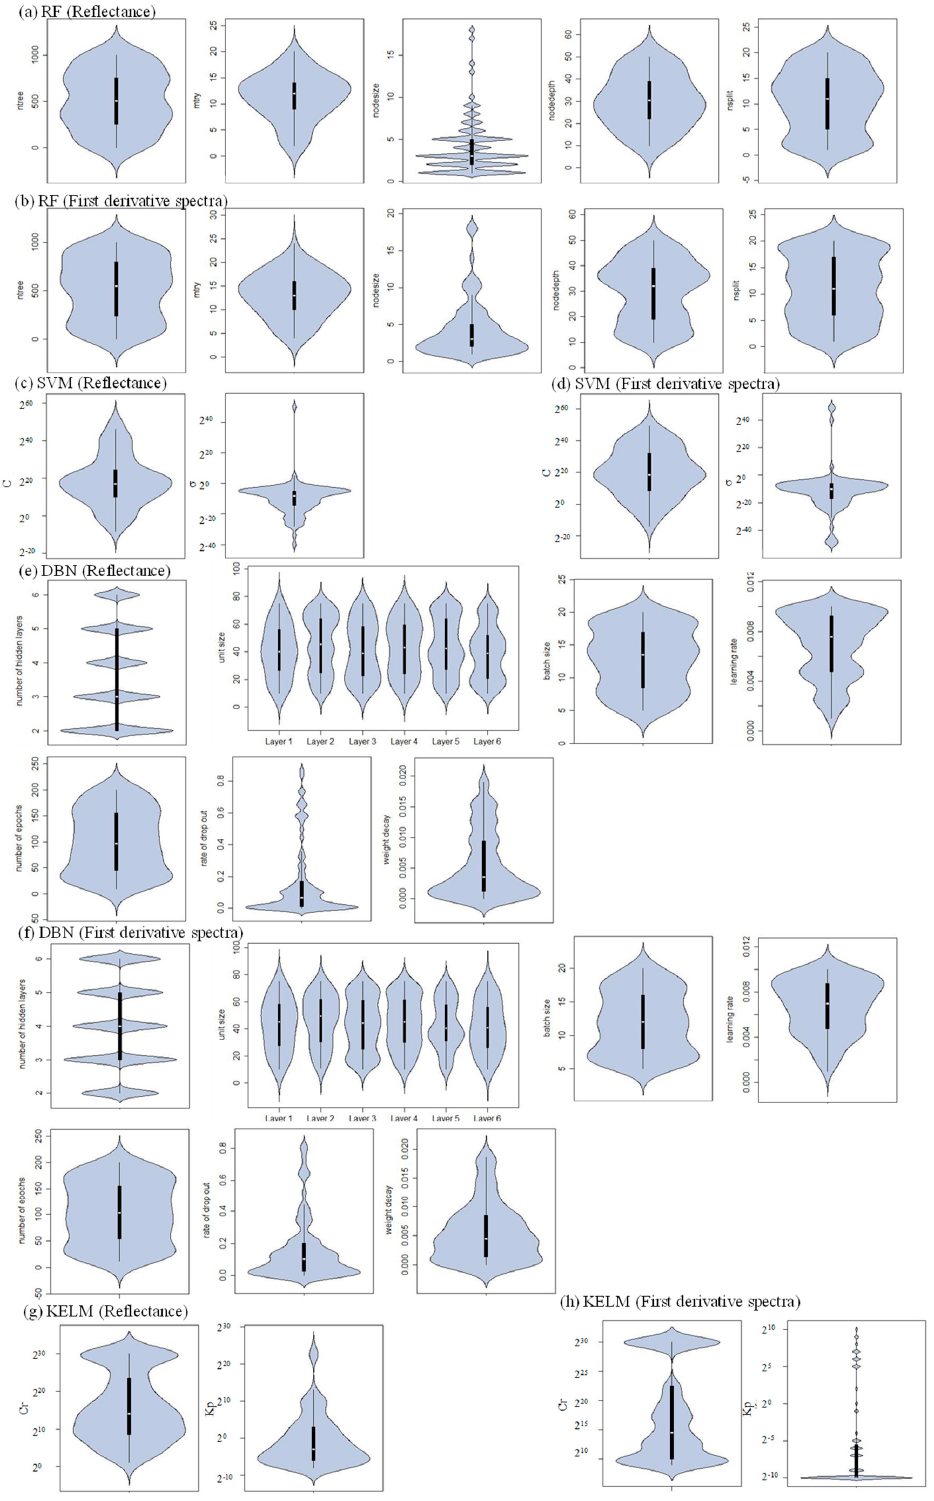
Figure 4. Distributions of selected hyperparameters based on Bayesian optimisation.